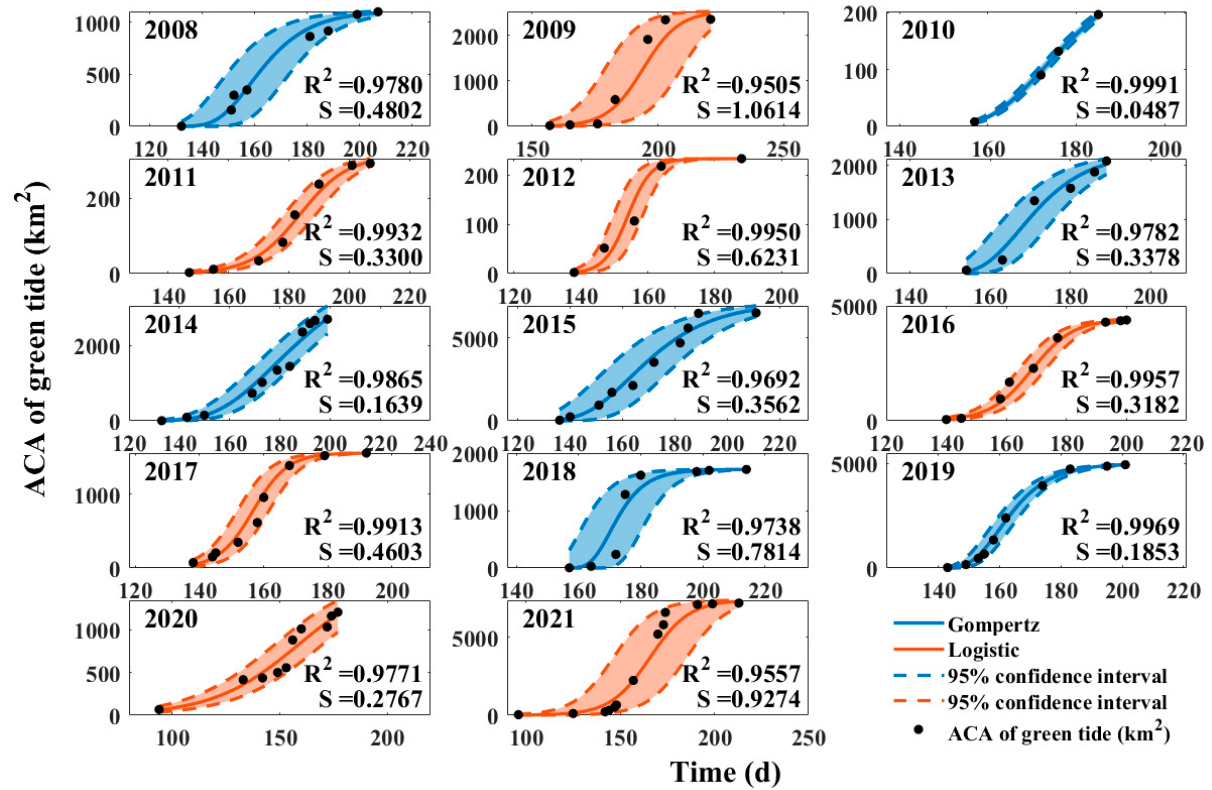
Figure 10. Growth curve fitting effect with 95% confidence interval. After determining the growth curve of the green tide cover area versus time, the duration of development of the green tide was estimated, and the approximate start and dissipation times of the green tide were projected. We found that the first-order derivative of the growth curve, i.e., the rate of increase in the green tide cover area, conformed to the normal distribution, so a Gaussian fit to the first-order derivative was performed to obtain the curve equation 𝑦′ (see Figure 11).